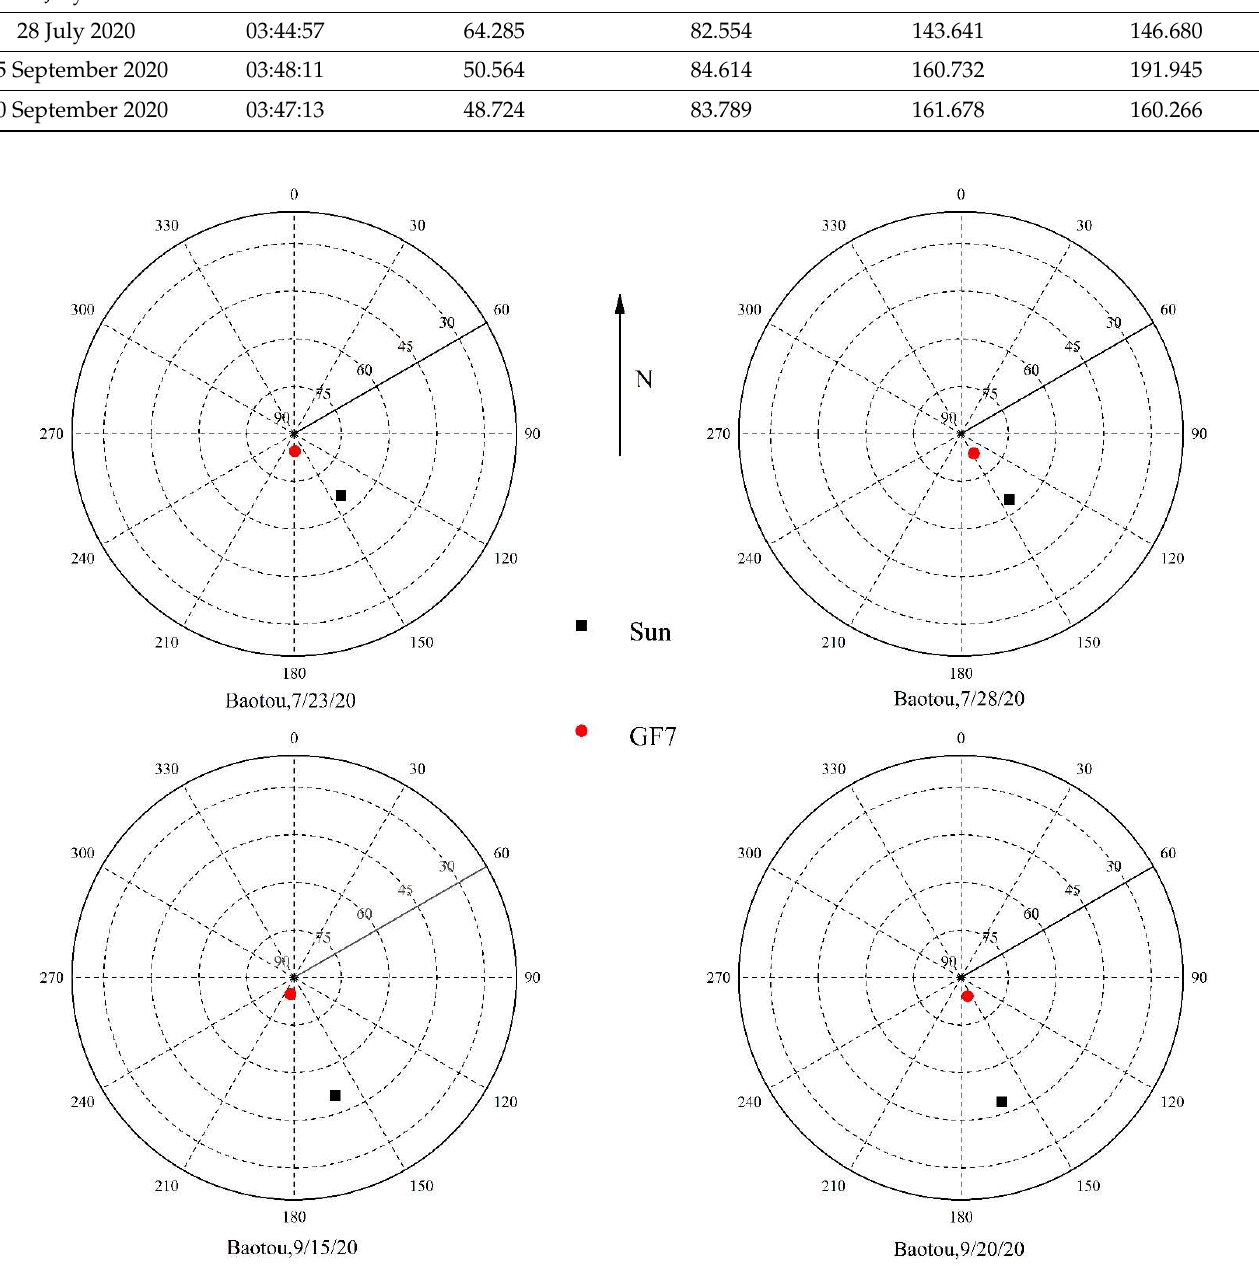
Figure 12. The GF-7 satellite Baotou site acquisition geometry. Table 5. The absolute radiometric calibration result of the GF-7 satellite at the Baotou site on July